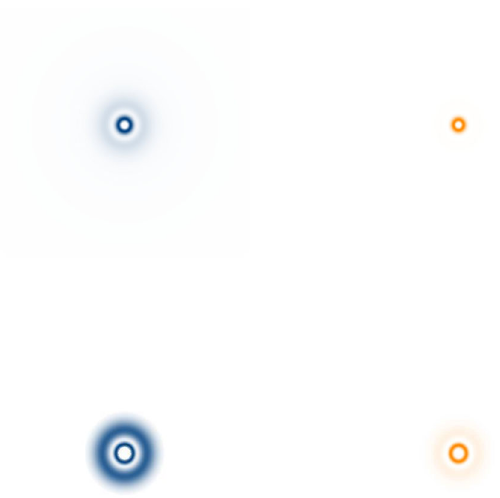
Fig. 20 The section passing through the center of the structure, repre- senting the electric field (left, blue) with e = 1 and the energy density (right, orange) associated to the model in Sect. 4.2.2 for σ = 5, α = 2, with k = 1 (top) and 2 (bottom). The intensity of the blue and orange colors increases with the increasing of the electric field and energy density,